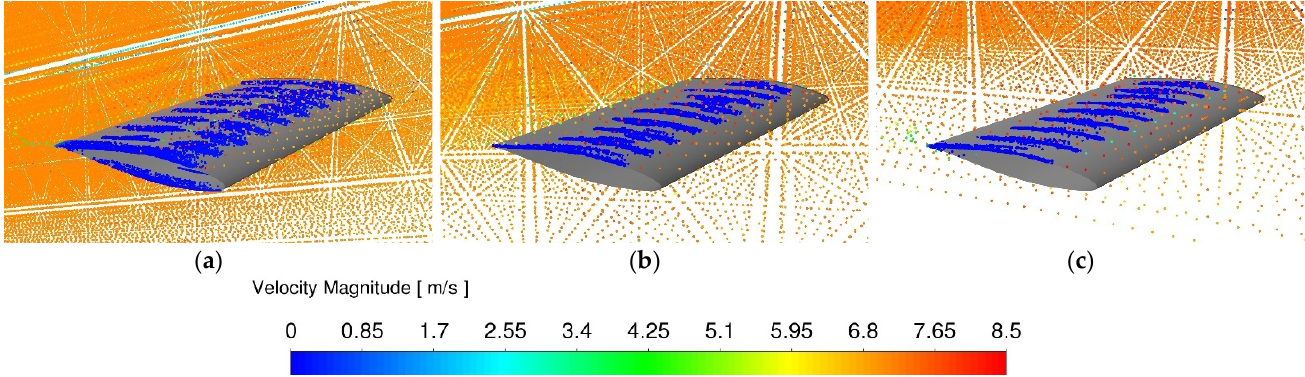
Figure 16. Velocity magnitude of water droplets over the original dimensions wing at angle of attack ( a ) 0°, ( b ) 8°, and ( c ) 16°.